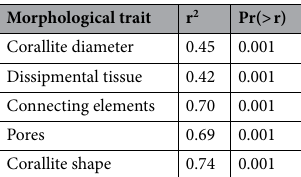
Table 1. Correlation of each trait to the principal coordinate ordination based on 999 random permutations.